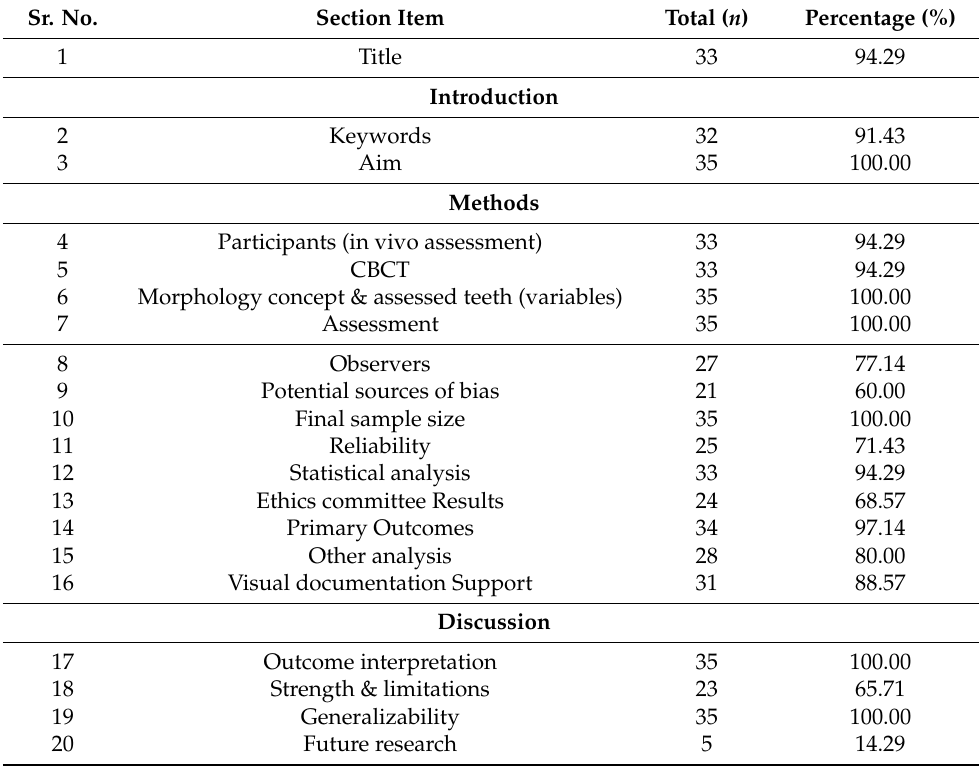
Table 3. Specific preferred reporting items for cross-sectional studies on root and root canal anatomy using cone-beam computed tomography